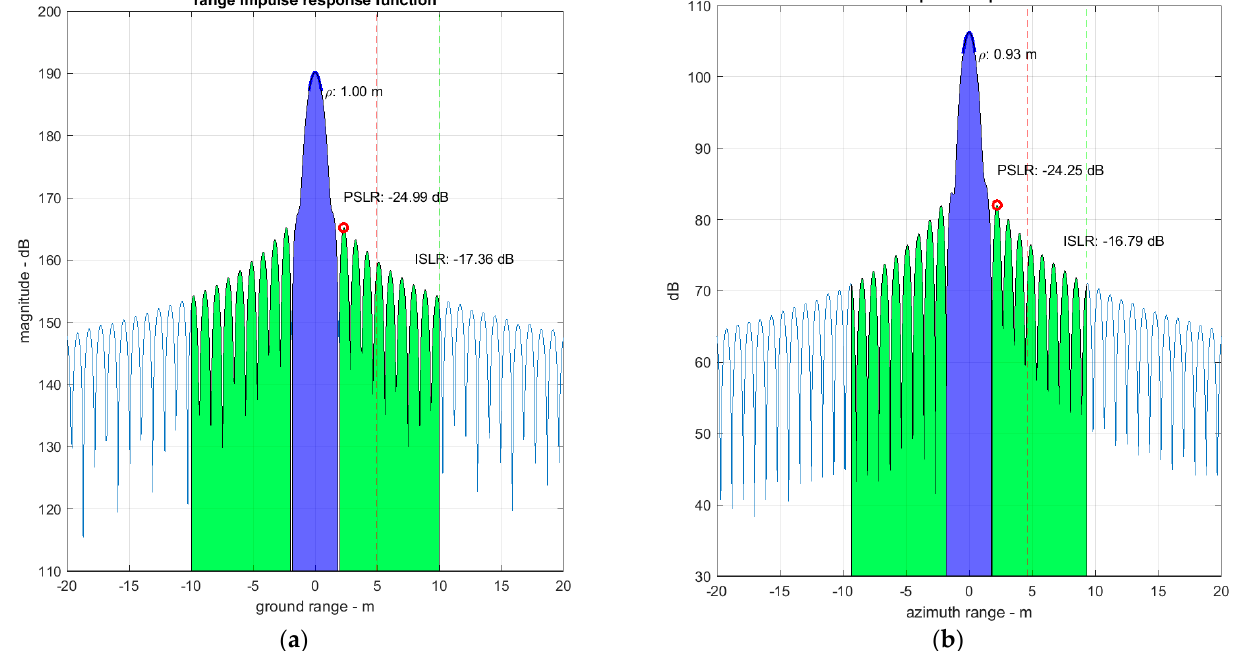
Figure 25. Impulse response function analysis in the ( a ) range and ( b ) azimuth of the S-STEP SAR payload in the high-resolution mode. The red circles indicate the peak side lobes.